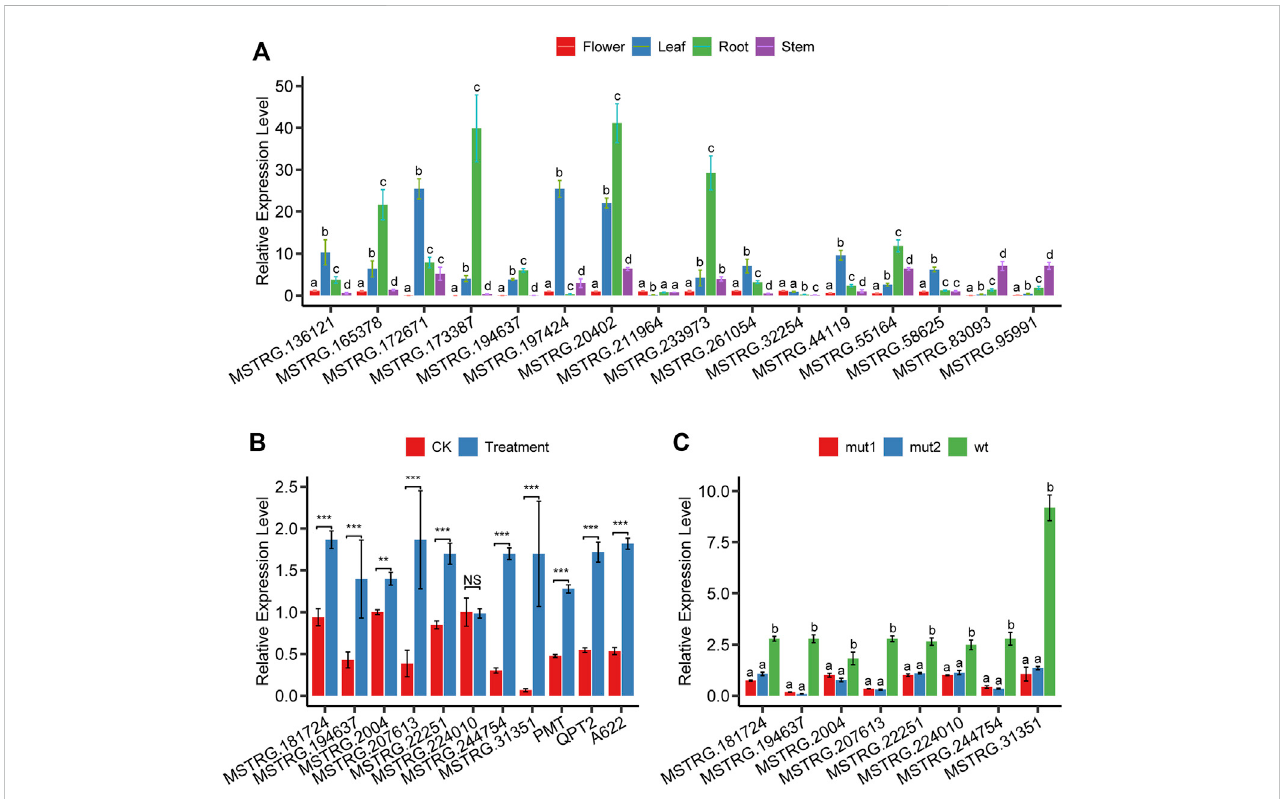
FIGURE 6 The relative expression level of lncRNAs and genes. (A) expression of 16 randomly selected lncRNAs in fl ower, leaf, root, and stem tissues, (B) expression of eight lncRNAs and three well-known nicotine biosynthesis protein-coding genes in root tissue after MeJA treatment, (C) expression of seven lncRNAs in root tissue of NtMYC2 mutation